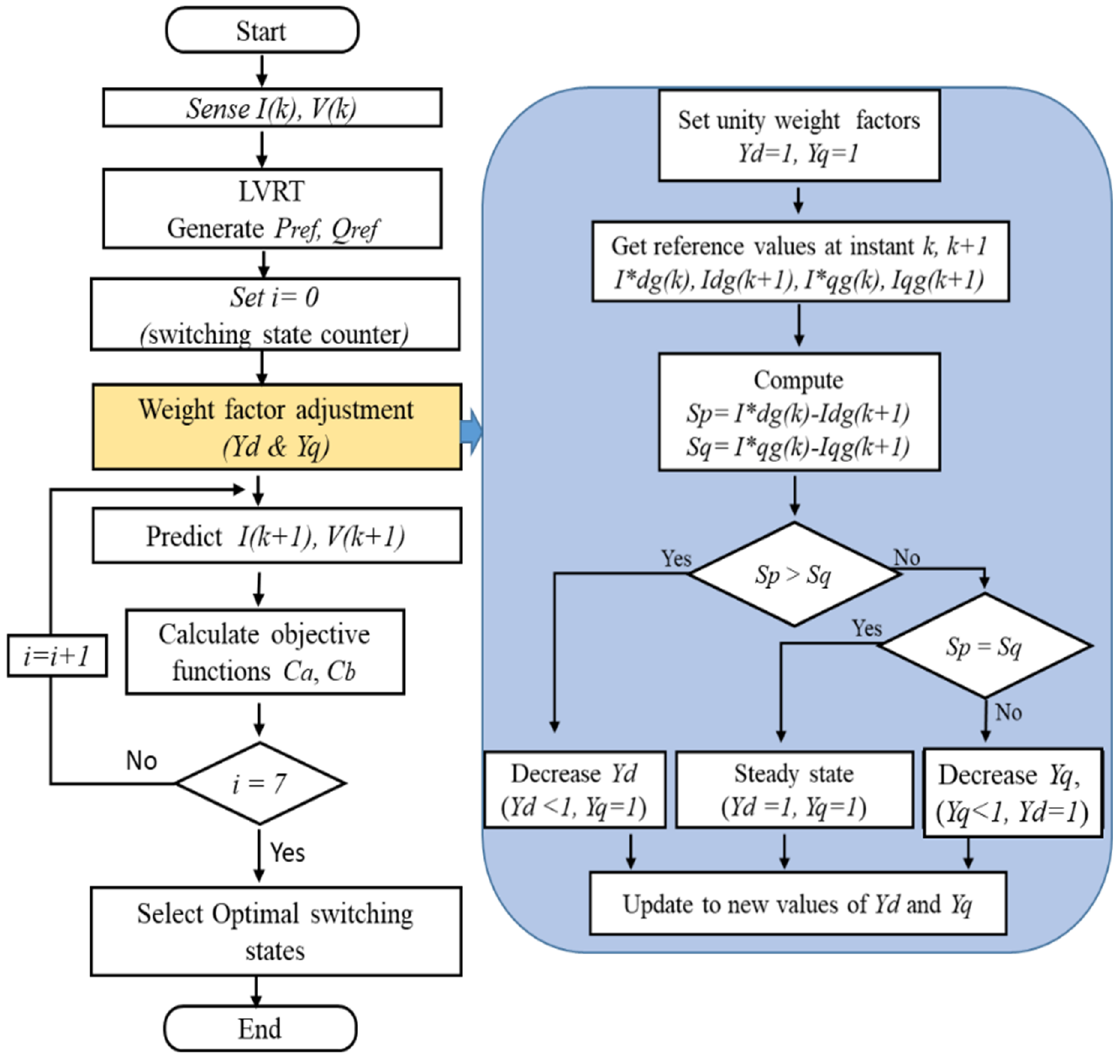
Figure 6. Flowchart of FCS-MPC with weight factor adjustment. Table 3. WFs assortment